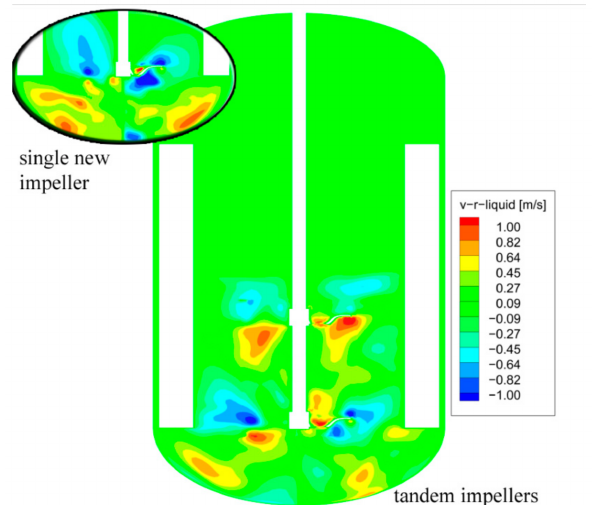
Figure 6. Radial velocity distribution of liquid phase, single new impeller vs. new impellers in tandem, instantaneous